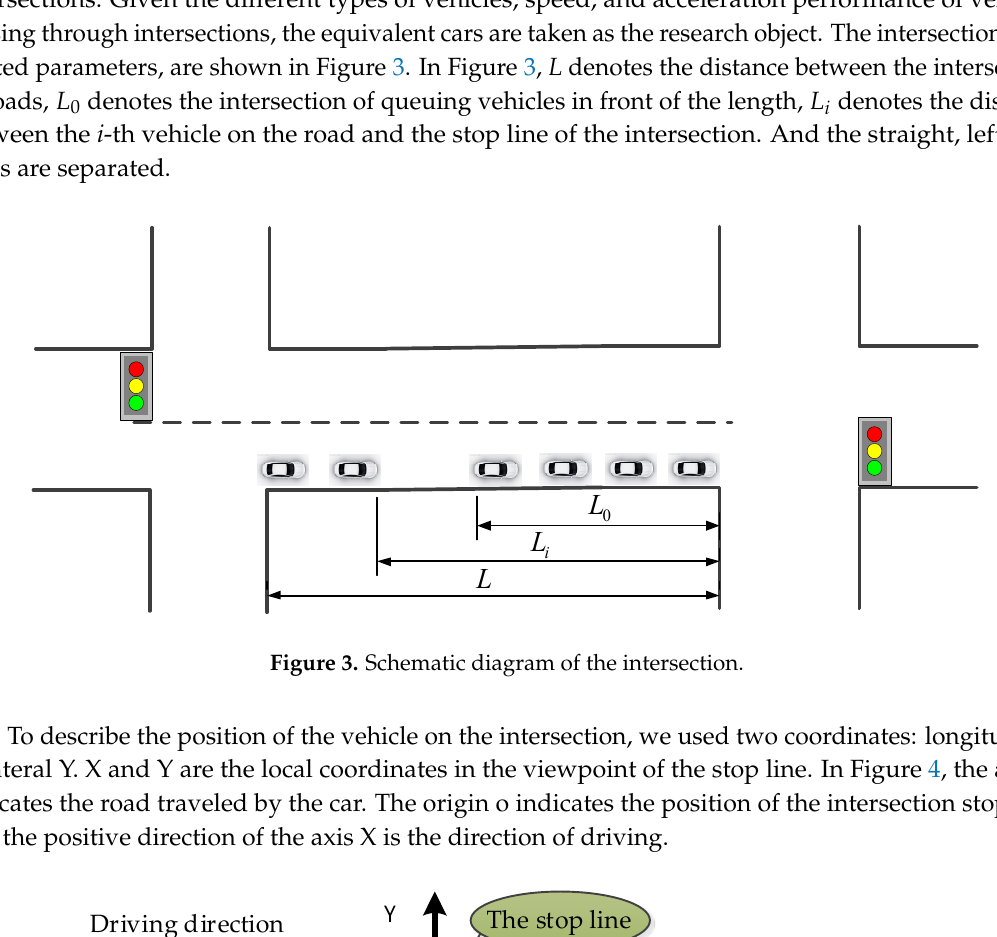
Figure 4. Intersection coordinates.